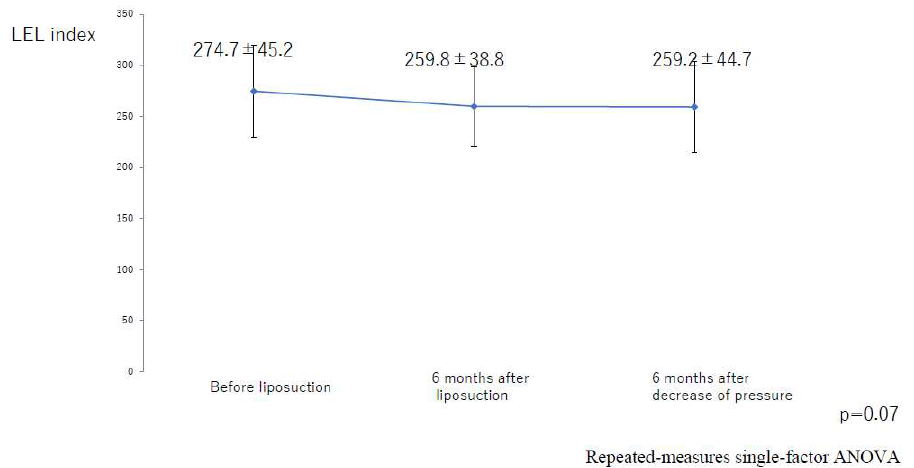
Figure 15. Changes in the LEL index over time in the group with successful liposuction. ANOVA, analysis of variance; LEL, lower extremity lymphedema.